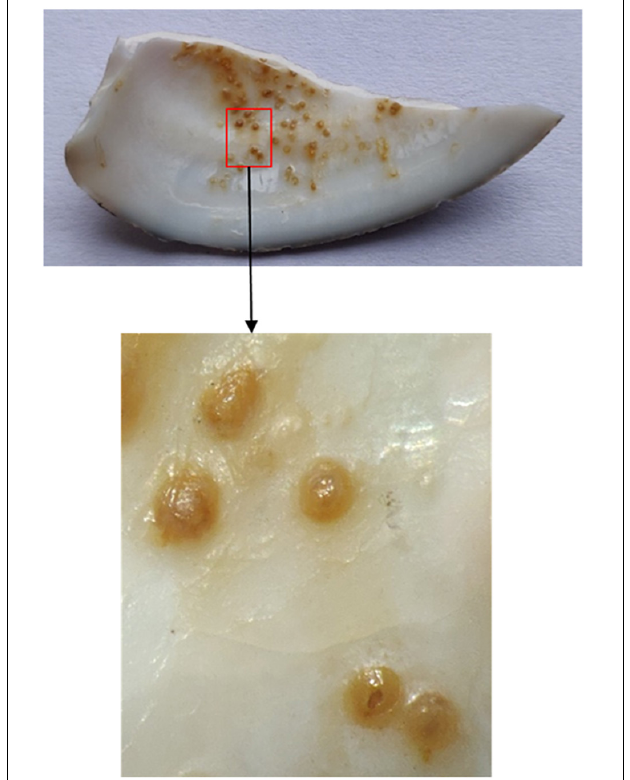
FIGURE 3 | Schematic diagram of shell sampling. Area A was selected as the experimental sample area and area B was used as the control sample area.